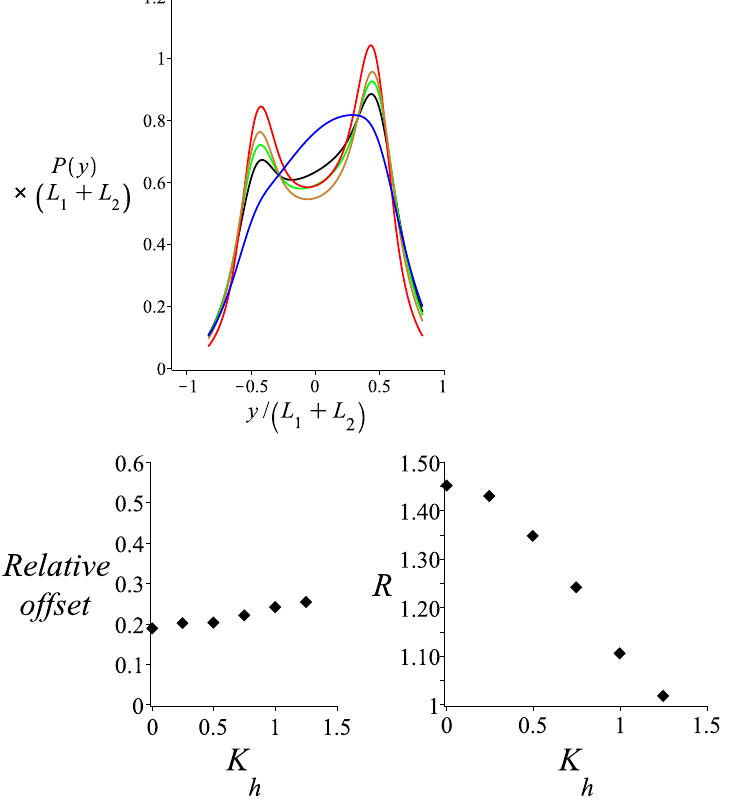
Figure 8. Upper panel : The probability density of the y coordinate of the position of the tip of two filaments jointed at a hinge point, as shown by Equation (16). The red, gold, green, black and blue colours correspond to K h = 0.005, K h = 0.5, K h = 0.75, K h = 1 and K h = 2, respectively. Lower left panel : The relative offset of the two peaks of the bimodal profile P rightmax as a function of K h . Lower right panel : The ratio of K h . The fixed parameters for all curves are: L 1 = 3 µ m; L 2 = 3 µ m; ω = 0; θ B = π K B = 0.5; γ 0 = 0; and l p 1 = l p 2 = 27 µ